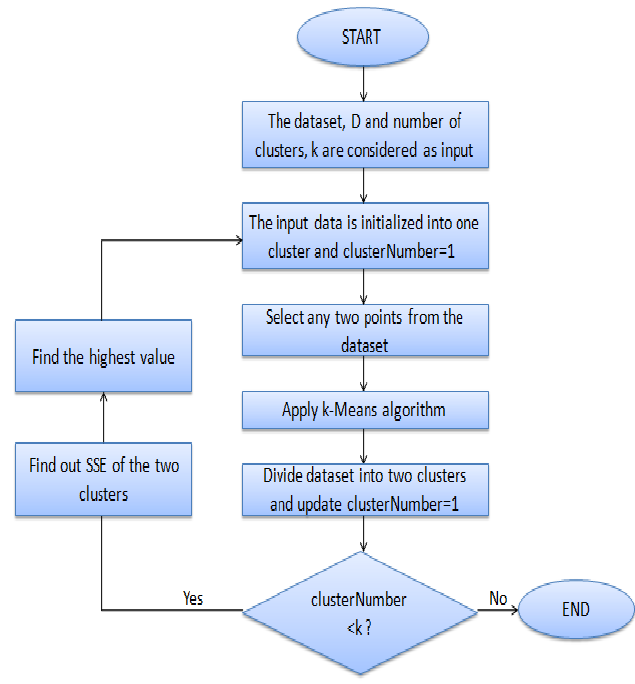
Fig. 13. Divisive k -means